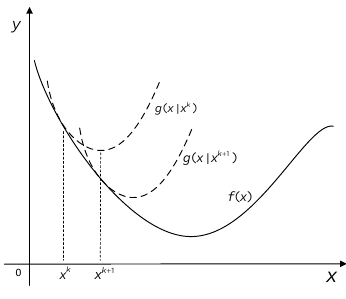
Figure 2. Illustration of MM